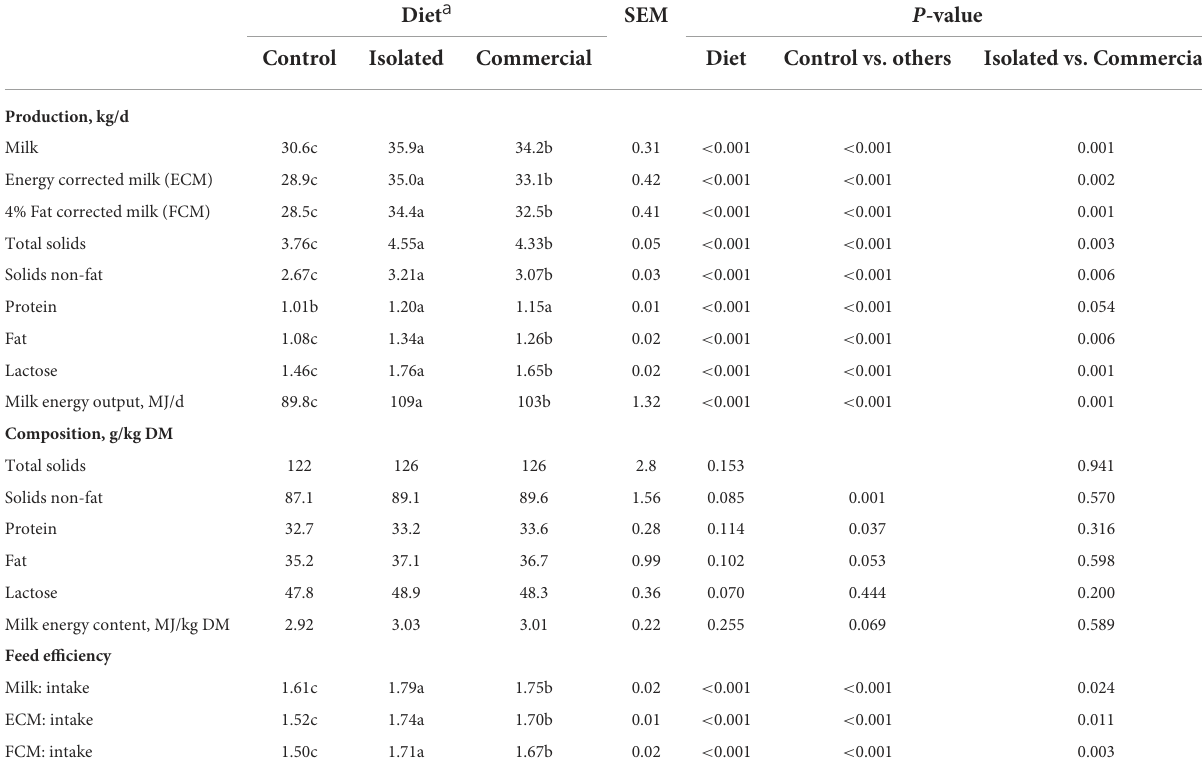
TABLE 5 Experiment 2: Milk production and composition, and feed efficiency of Holstein cows fed diets supplemented with isolated or commercial E. faecium as probiotics. Diet a SEM P -value Control Isolated Commercial Diet Control vs. others Isolated vs. Commercial